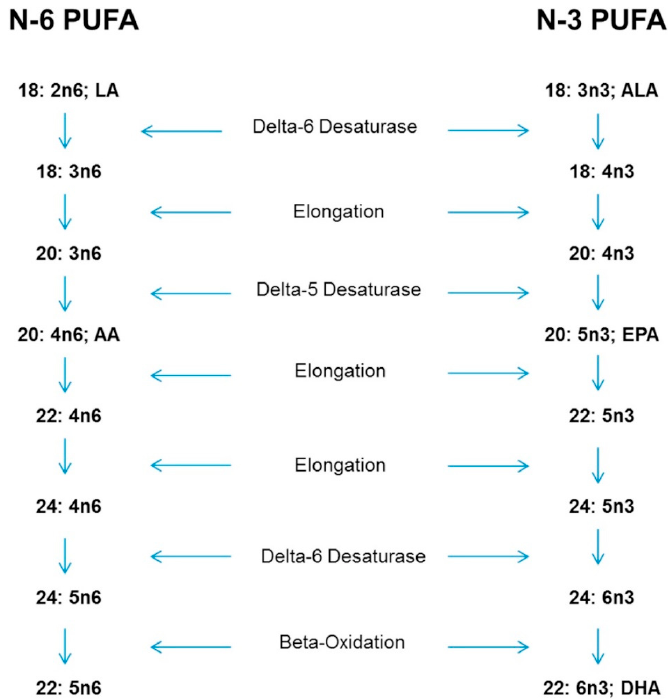
Figure 1. The elongation and desaturation of the essential fatty acids, linoleic acid (LA) and alpha-linolenic acid (ALA). AA: arachidonic acid; EPA: eicosapentaenoic acid; DHA: docosahexaenoic acid; PUFA: polyunsaturated fatty acids. Permission by authors and Elsevier